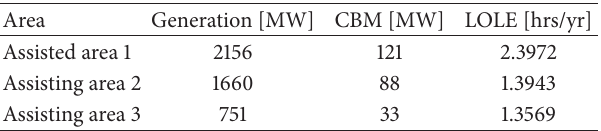
Table 2: CBM results considering interconnected system reliability using the method introduced in